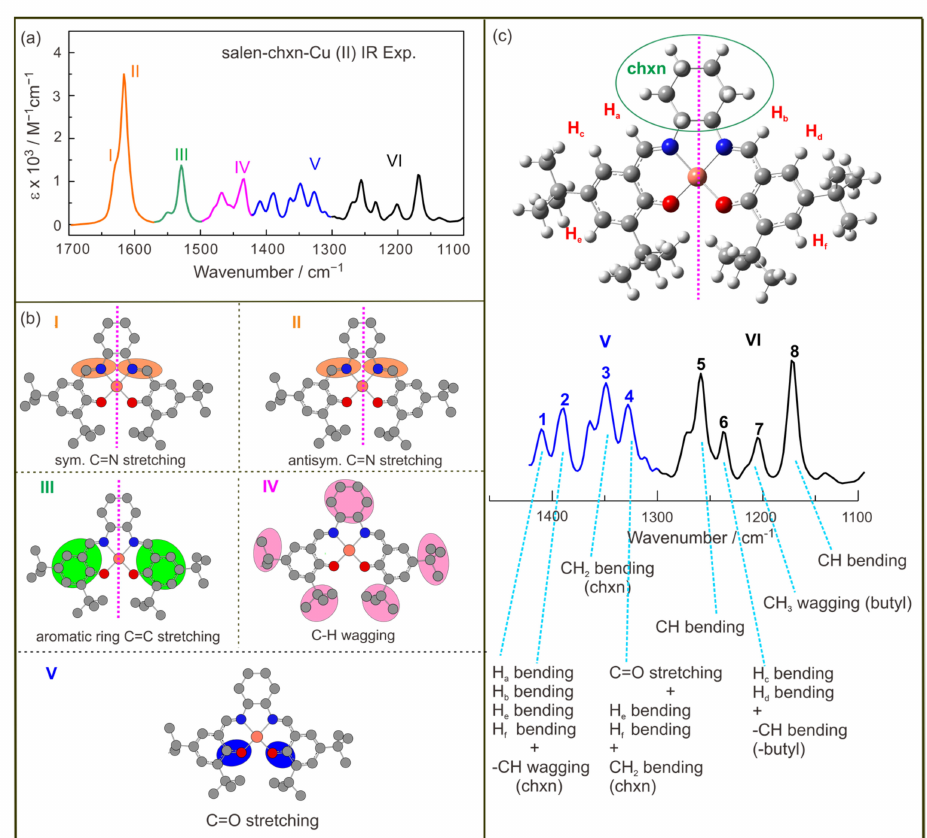
Figure 7. ( a ) The IR spectrum of salen-chxn-Cu(II) in the 1700–1100 cm − 1 region is divided into six parts from I to VI. ( b ) The molecular parts related to I to V are coloured. ( c ) The main vibrational modes of salen-chxn-Cu(II) in the 1450–1100 cm − 1 region. The main IR bands in the 1100–1450 cm − 1 region are labelled as “1” to “8” to aid the